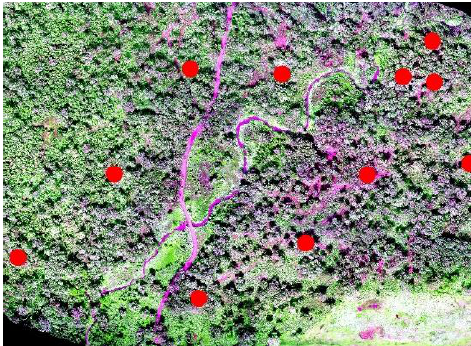
Figure 3. Sample plot distribution (shown in red colour circle)